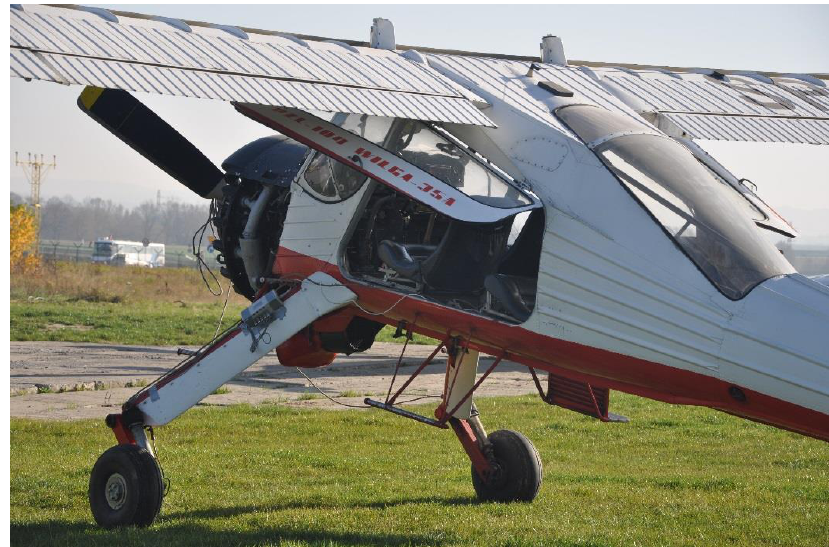
Figure 5. The wheel force sensor installed on the test airplane, ready for the